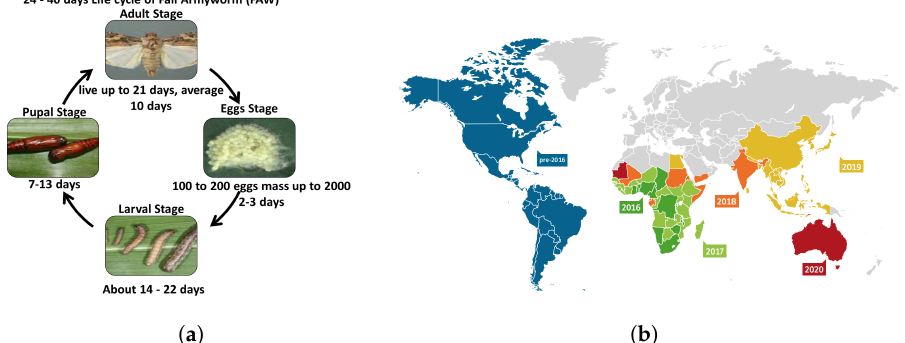
Figure 1. Lifecycle and geographic distribution of proposed insect pest case study (fall armyworm). ( a ) Lifecycle of fall armyworm [46]; ( b ) Geographic distribution as of May 2020